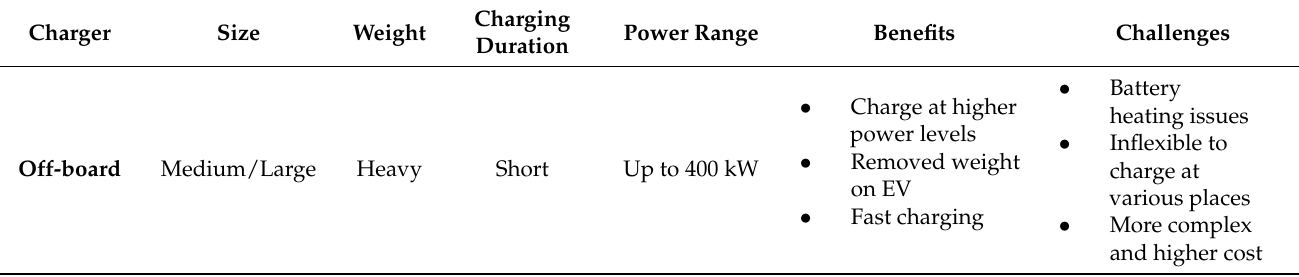
Figure 2. EV charging systems, including on-board and off-board chargers. Table 1. Comparison between on-board and off-board battery chargers.